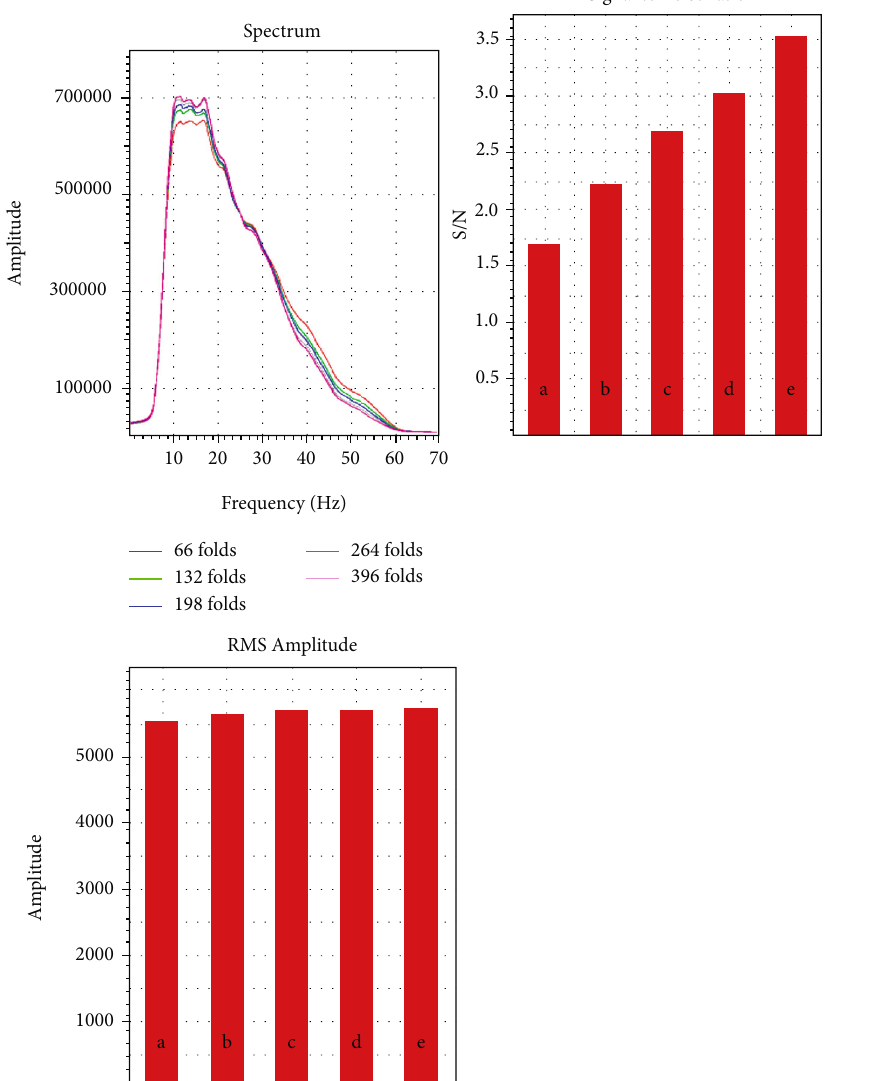
Figure 9: Quantitative analysis of the seismic sections with di ff erent folds (a: 66 folds; b: 132 folds; c: 198 folds; d: 264 folds; e: 396 folds).